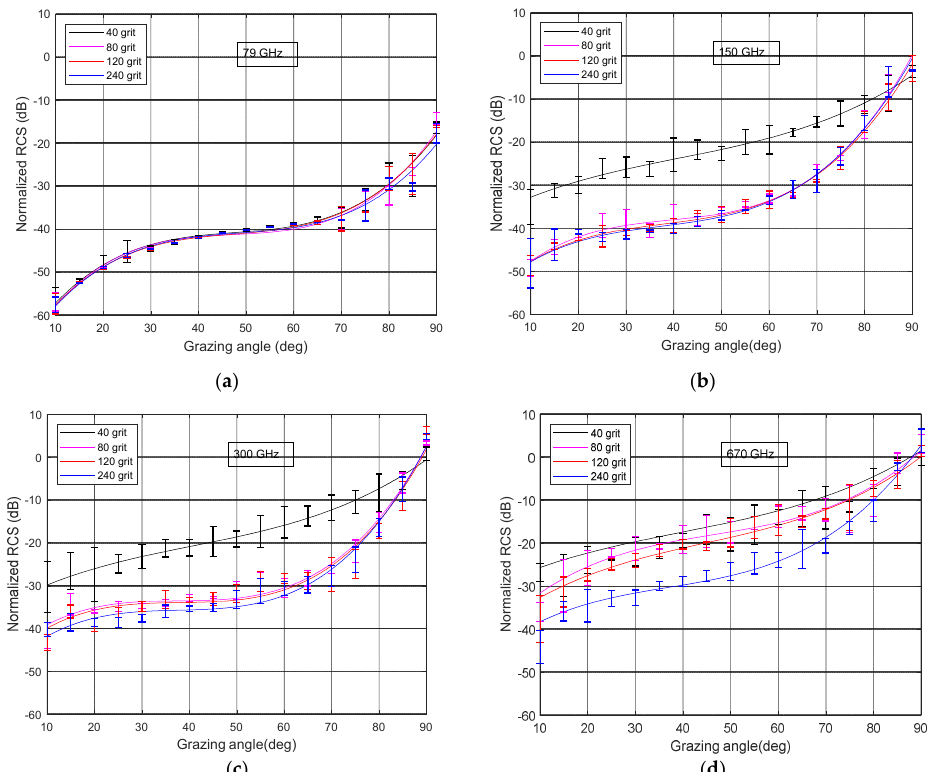
Figure 7. The normalized RCS σ ° : ( a ) 79 GHz, ( b ) 150 GHz, ( c ) 300 GHz, and ( d ) 670 GHz. Graphs presented in Figure 7d significantly differ from the previous results (Figure 7a–c). Reflection from all types of sandpaper, except for sandpaper with grit 240, is predominantly diffuse. According to the Fraunhofer criterion, this reflection pattern is preserved, depending on the size of the grit, until the angle decreases to 15°–25°. With a further decrease in the grazing angle, the normalized RCS rapidly decreases. At the same time, an expected trend for return power is observed: the higher the roughness of the sur- face, the greater the power of the reflected signal. Reflection from 240-grit sandpaper is generally specular; the graph is characterized by a peak at high grazing angles with the width depending on the width of the antenna beam, and a rapid decrease at lower angles. Figure 8 shows discrete values of normalized RCS ° versus electromagnetic rough- ness (see Table 3) for different sandpapers at a grazing angle of 10°. The general trend for the normalized RCS to increase with increasing kh is clearly seen. Figure 8. The normalized RCS σ ° as a function of electromagnetic roughness at a grazing angle of 10°. 4.2. Measured and Calculated Normalized RCS Figure 9 depicts the measured and calculated normalized RCS at different signal po- larizations: σ ° , σ ° , and σ ° , as a function of grazing angle increment. In this section, we restrict ourselves to considering reflection from sandpaper with two extreme values of roughness (grit 40 and grit 240) at two frequencies (150 GHz and 600 GHz), since the above examples illustrate well the general dependencies. The theoretical values are calcu- lated using the empirical model explained in Section 3.2.